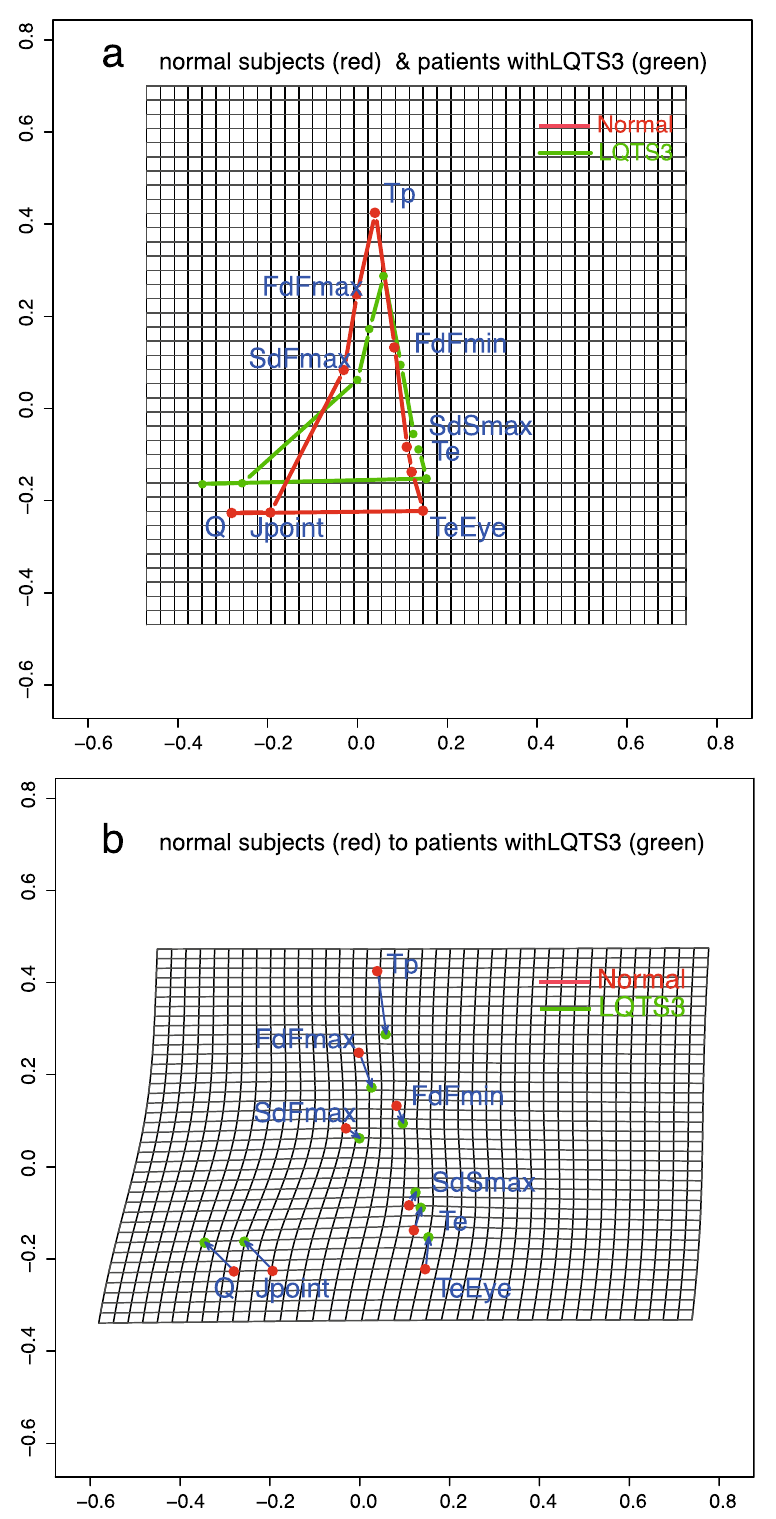
Figure 4. ( a ) Shows the mean shape of the T-wave in the normal subjects (red) and the mean shape of the T-wave in the LQTS3 patients (green) by full GPA. ( b ) Shows thin-plate spline transformation grids to minimize the mixed energy from the normal mean shape (red) to the LQTS3 patient mean shape (green), with blue arrows drawn from the normal subject mean (red) to the LQTS3 patient mean (green). The shape changes have not been magnified. R version 4.0.2 URL https:// www.R- proje ct.